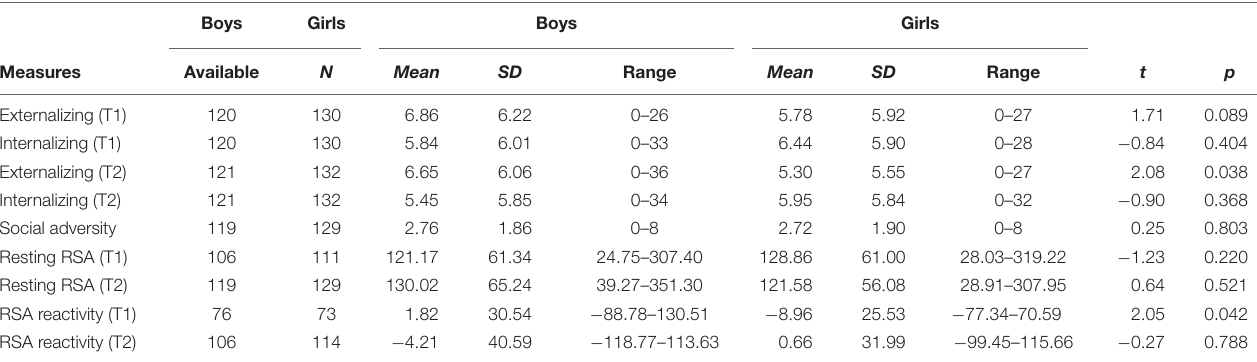
TABLE 1 | Gender differences in study variables.